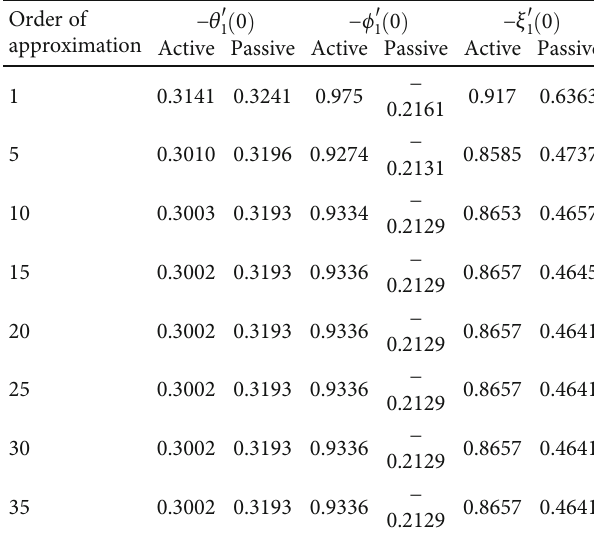
Table 2: Order of approximation for − θ Order of